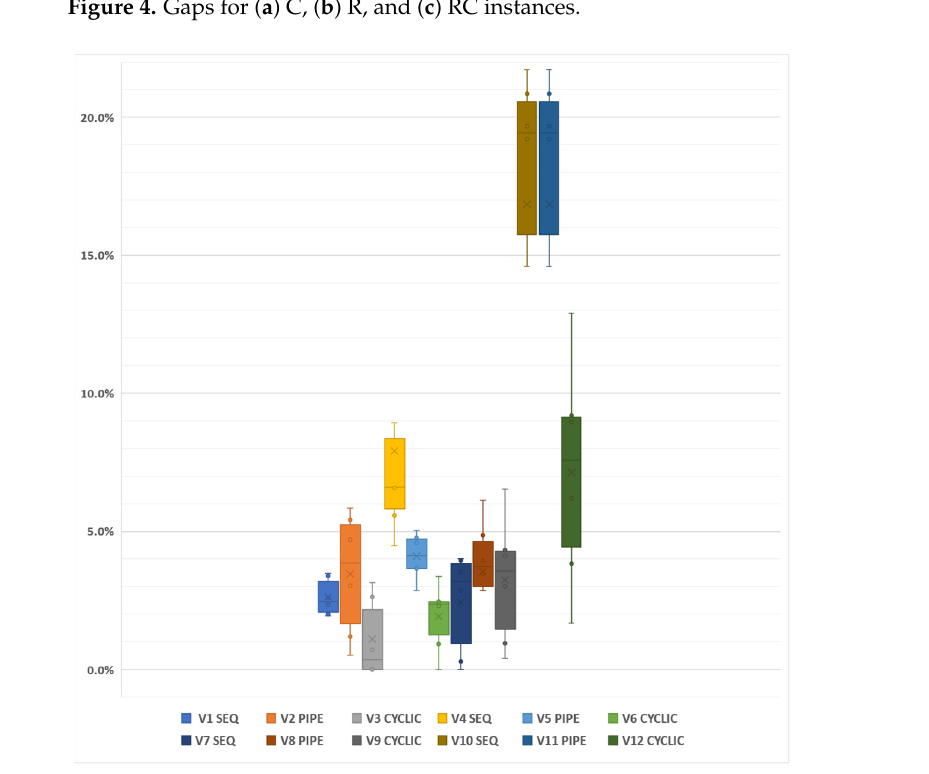
Figure 5. Gaps for selected large-sized instances .